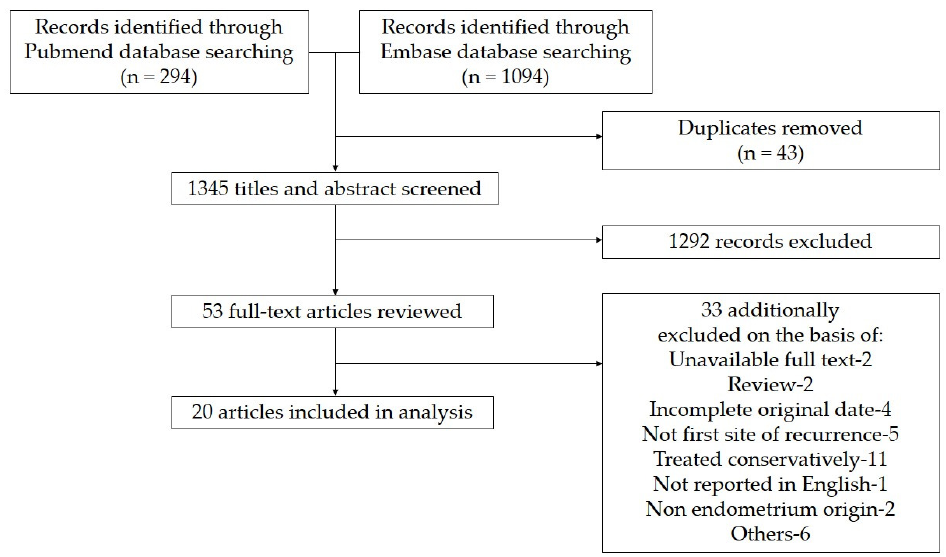
Figure 1. Flow diagram of the studies’